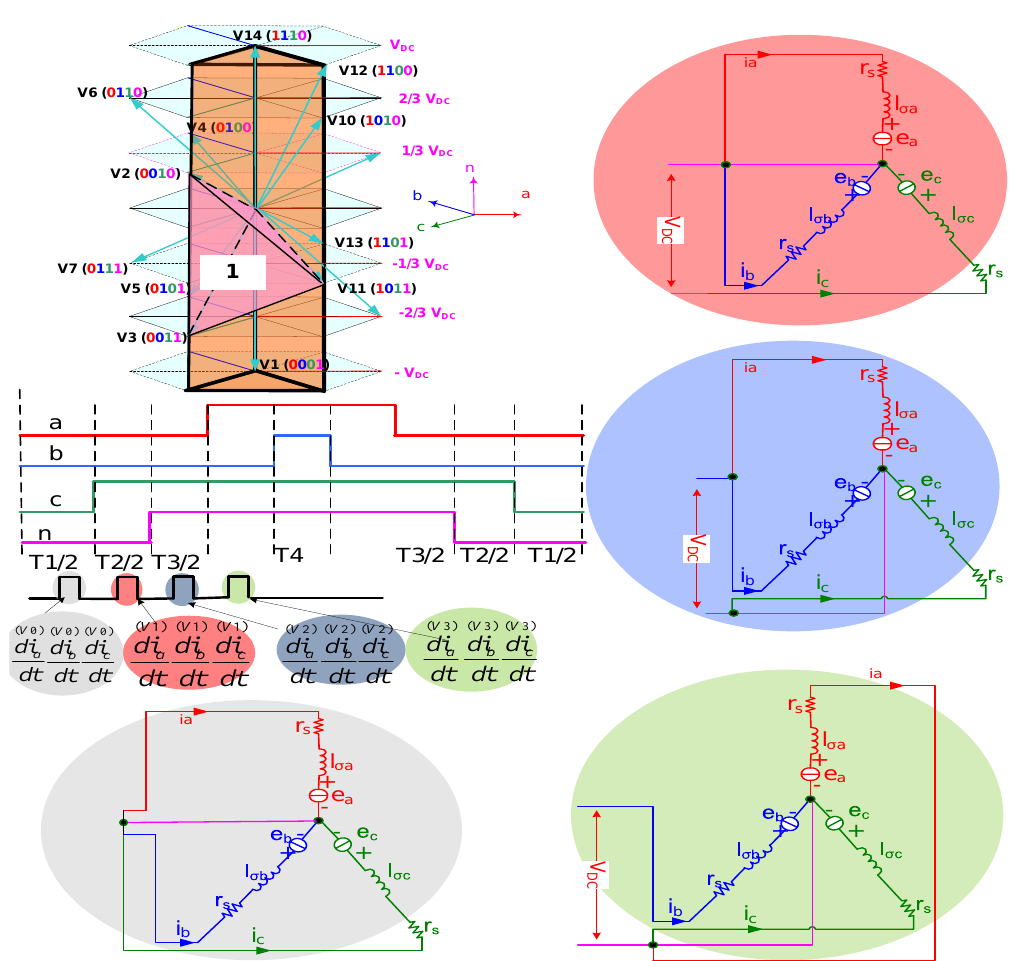
Figure 8. Switching sequence for the case when the reference voltage exists in prism 5 and tetrahedron 1 in 3D SVM and the stator dynamic circuits under application of the voltage vectors V0, V1, V2, and V3 in normal operating conditions.